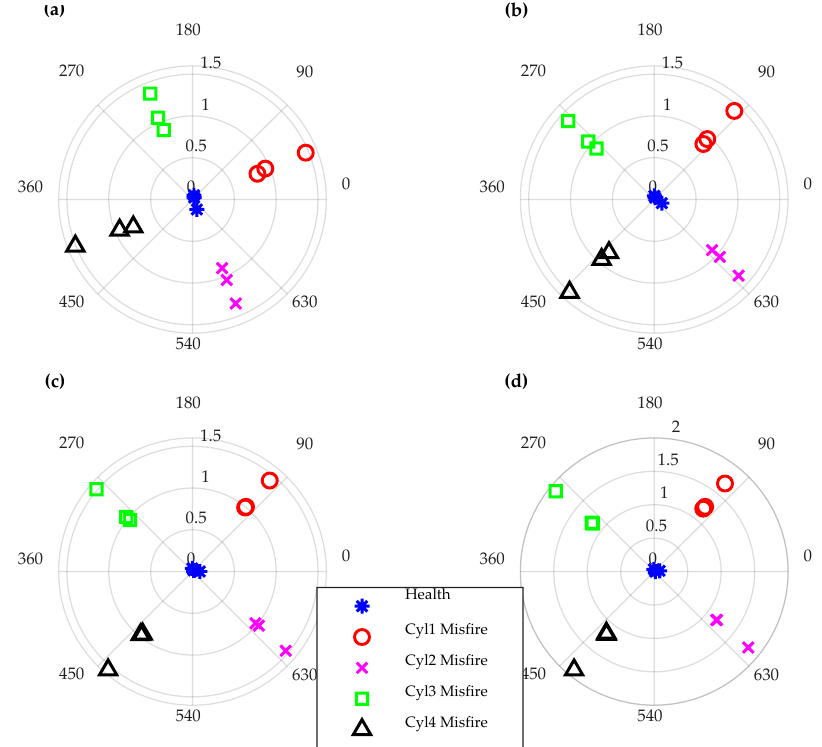
Figure 14. Polar plotting of the fault indicators at 1000 rpm: ( a ) 0 Nm; ( b ) 105 Nm; ( c ) 210 Nm; ( d ) 315 Nm.